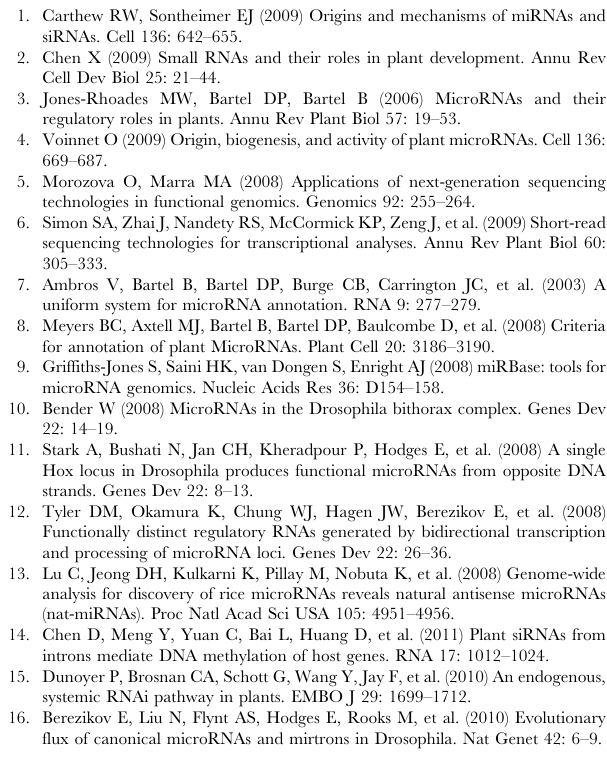
Data S2 Randomly selected 1000 sequences antisense to the protein-coding genes in rice. (TXT) Data S3 Retained random sequences after secondary structure prediction in Arabidopsis . (TXT) Data S4 Retained random sequences after secondary structure prediction in rice. (TXT) Data S5 Random sequences possessing perfectly- matched small RNAs in Arabidopsis . (TXT) Data S6 Random sequences possessing perfectly- matched small RNAs in rice. (TXT) Data S7 Dependence of the accumulation levels of certain RC-miRNA(*)s on DCL1, but not DCL3 and RDR2, and their association with AGO1 protein.